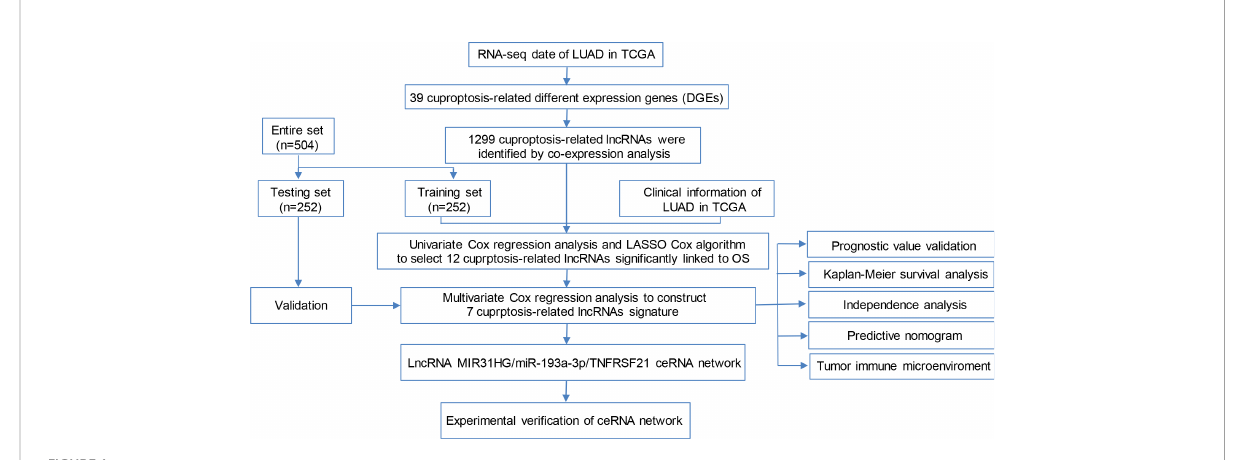
FIGURE 1 Flow chart of the study.